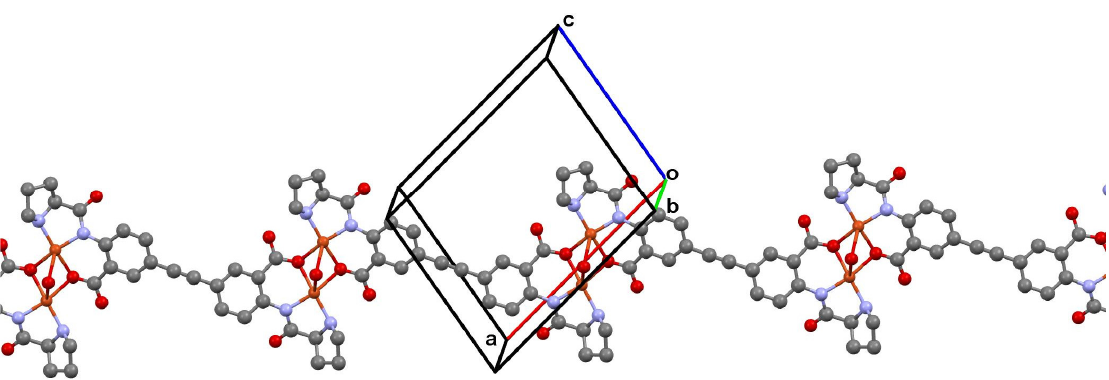
Figure 2. A portion of the crystal structure of [ Cu 2 (EDPB)•H 2 O] n , showing the atomic numbering of the Cu, O and N atoms.